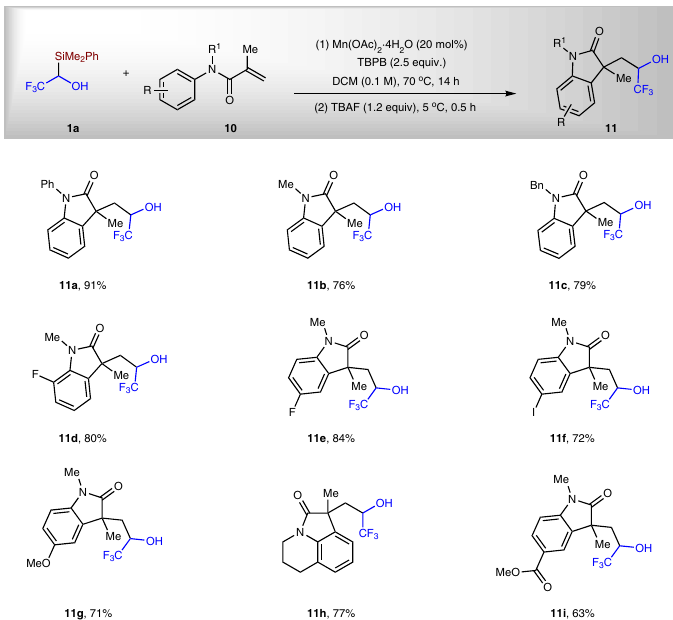
Fig. 5 Synthesis of α -tri fl uoromethylated alkyl alcohols. All reactions were run under the standard conditions with 1a/10 =